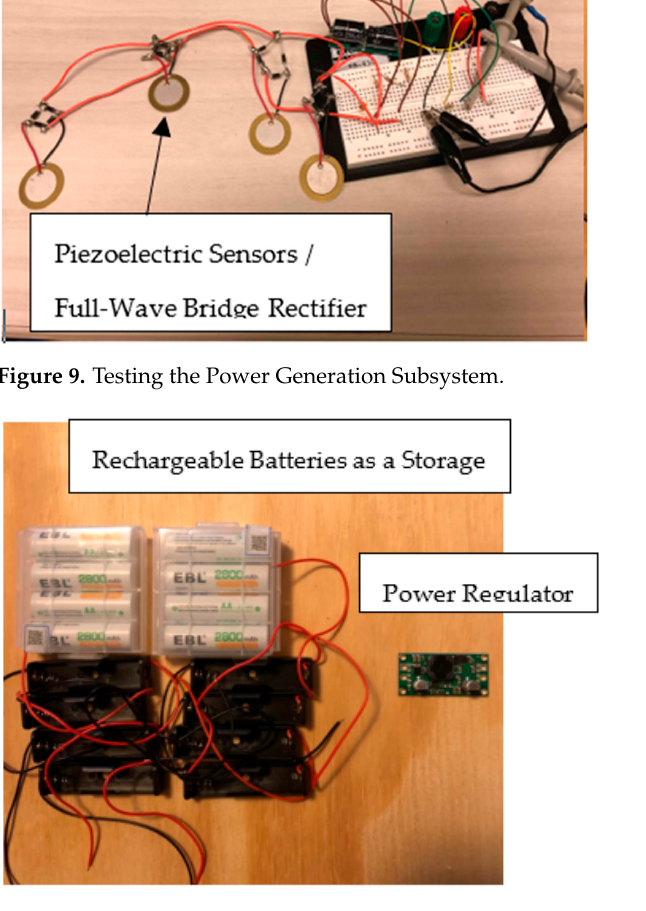
Figure 10. The Storage Subsystem.